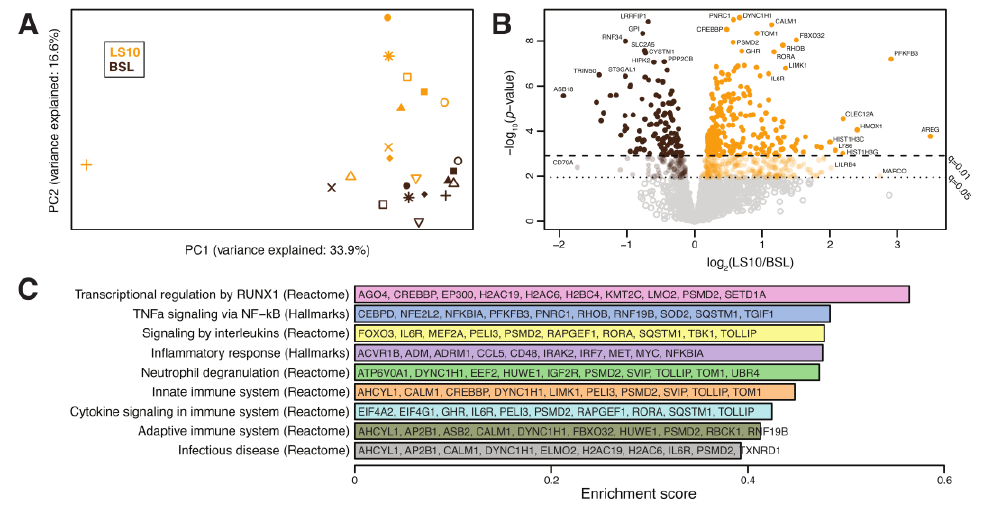
Figure 9. ( A ) Principal component analysis of the transcriptomes from 11 subjects at baseline and after 10 days of ULLS. ( B ) Volcano plot showing differentially expressed genes between ULLS and baseline. Genes with the most significant and/or largest fold-change differences are annotated. ( C ) Differentially enriched pathways. For each pathway, we display in alphabetical order the 10 most significant differentially expressed genes (selected amongst GSEA leading edge genes with differential gene expression q < 0.05). n = 11 male subjects; gene set enrichment analysis.